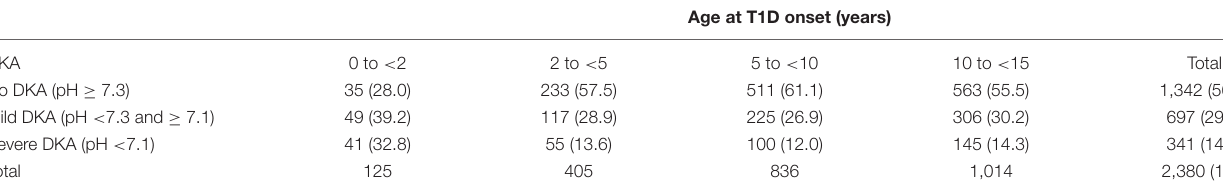
TABLE 1 | Prevalence (%) of DKA and age at T1D onset in children in Austria between 2012 and 2020. DKA 0 to < 2 2 to < 5 5 to < 10 10 to < 15 Total No DKA (pH ≥ 7.3) 35 (28.0) Mild DKA (pH < 7.3 and ≥ 7.1) Severe DKA (pH < 7.1)